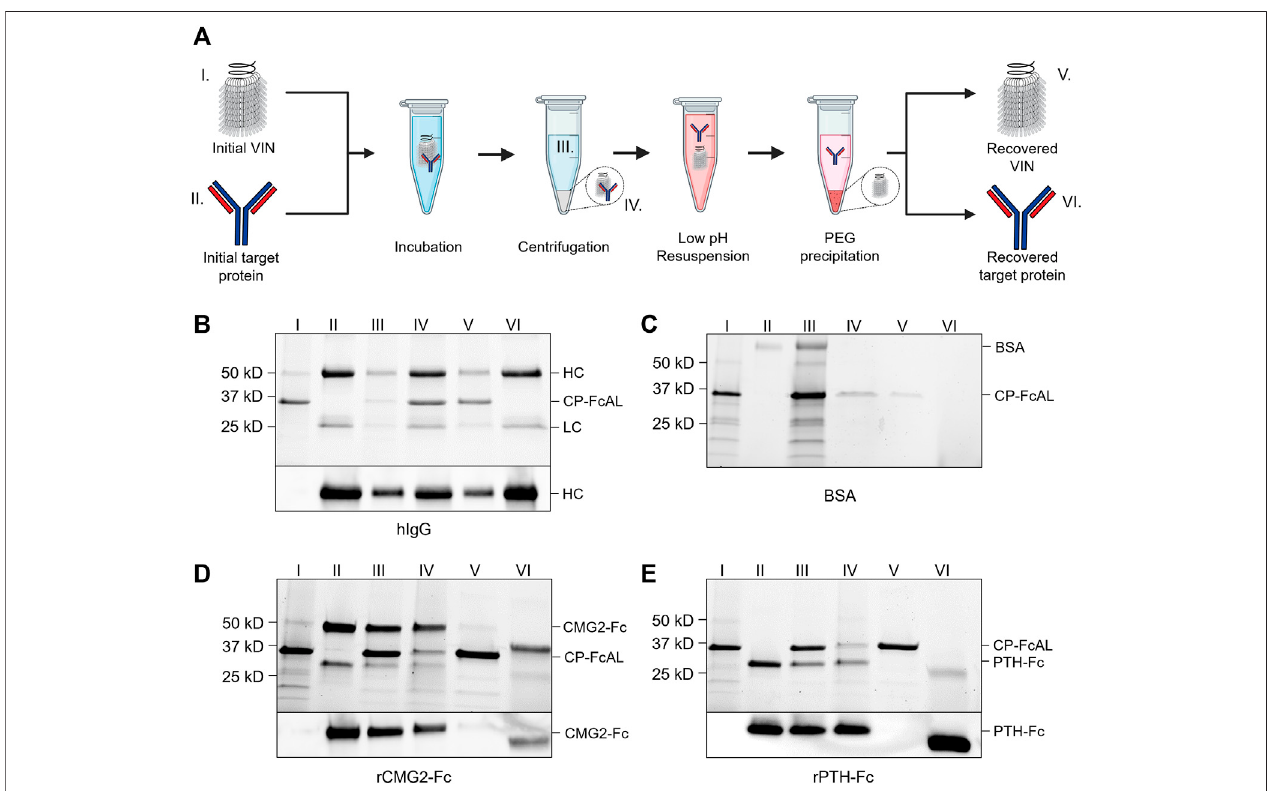
FIGURE 2 | Plant virus-based immunosorbent nanoparticle (VIN)-based capture and elution of Fc-proteins from a puri fi ed solution. (A) An illustration of the VIN- based capture and elutionthat indicates samplepoints. SDS-PAGE (top) and Westernblot (bottom) results ofVIN-based capture and elutionwith pre-puri fi ed targets of (B) human immunoglobulin G (hIgG) — reduced into heavy chain (HC) and light chain (LC) constituents, (C) bovine serum albumin (BSA), (D) plant-expressed recombinant capillary morphogenesis protein Fc-fusion (rCMG2-Fc), and (E) plant-expressed recombinant parathyroid hormone Fc-fusion (rPTH-Fc).